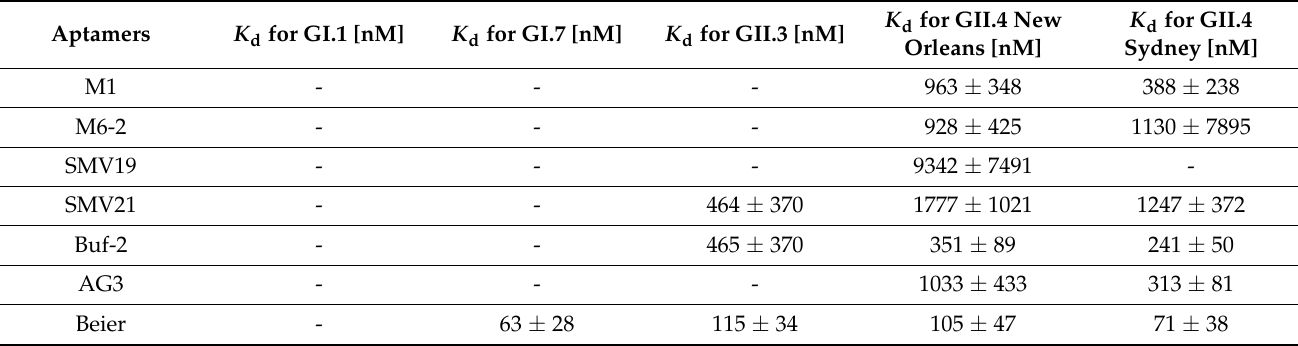
Table 2. K d determined for selected NoV aptamers and VLPs of five different genotypes. When overall binding did not exceed 10%, and a saturation-plateau of the binding curve was not observed, K d s were not determined as indicated by a dash